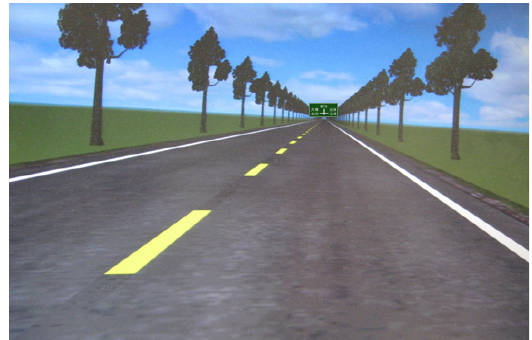
Fig.1. Simulated driving environment used in this